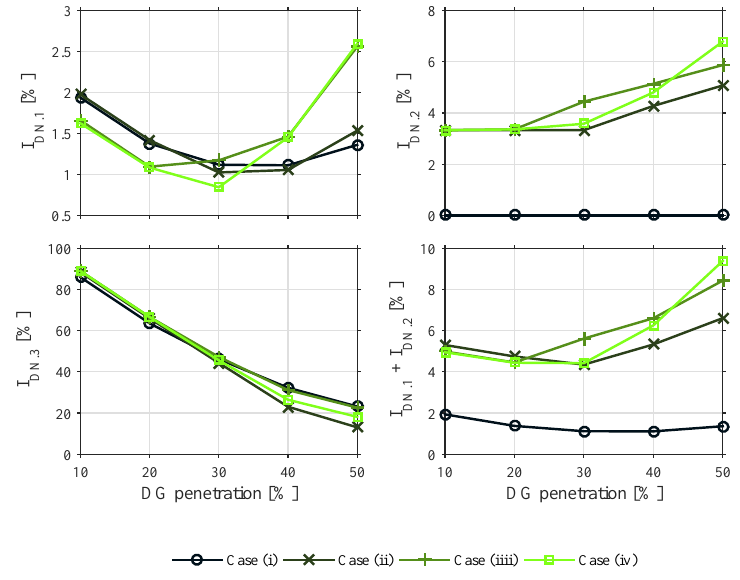
Figure 10. Trend of diverse DN related metrics with respect to DG penetration